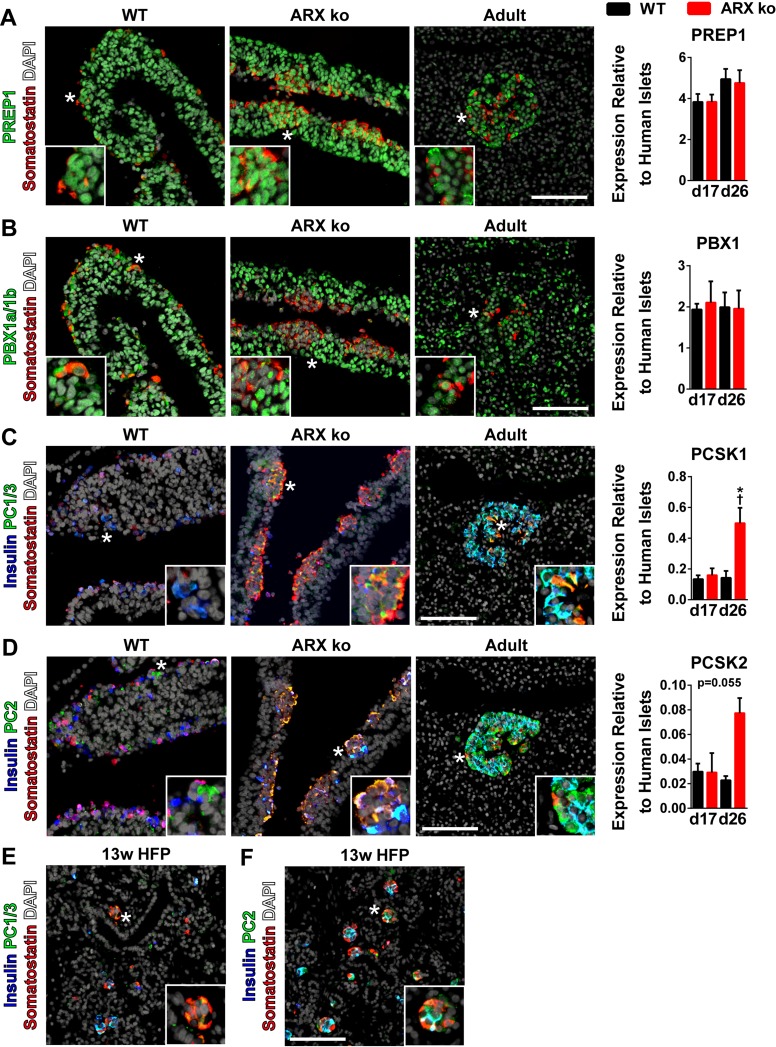
Expression of PREP1, PBX1 and Processing of Somatostatin in ARX ko hESCs.(A—D) Immunostaining of PREP1, PBX1a/1b, PC1/3, PC2 (all green), somatostatin (red), and insulin (blue) in 26 day differentiated wild type (WT) and ARX knockout (ARX ko) cells, and adult human pancreatic tissue. RT-qPCR of day 17 and day 26 whole population samples examining the expression of transcription factors believed to be involved expression and processing of somatostatin. Wild type (WT; black bars) and ARX ko clone 1 (ARX ko; red bars) cell samples relative to adult human islets expression levels. † indicates p < 0.05 within the genotype over time, * indicates p < 0.05 wild type vs ARX ko at given culture day, N = 4 per group. (E and F) Immunostaining of 13 week human fetal pancreatic tissue for expression of PC1/3 and PC2 (both green), somatostatin (red), and insulin (blue). DAPI is white in all images. Inset is a ~3x enlarged portion from the region indicated by the star. Scale bar is 100 μm for all panels.